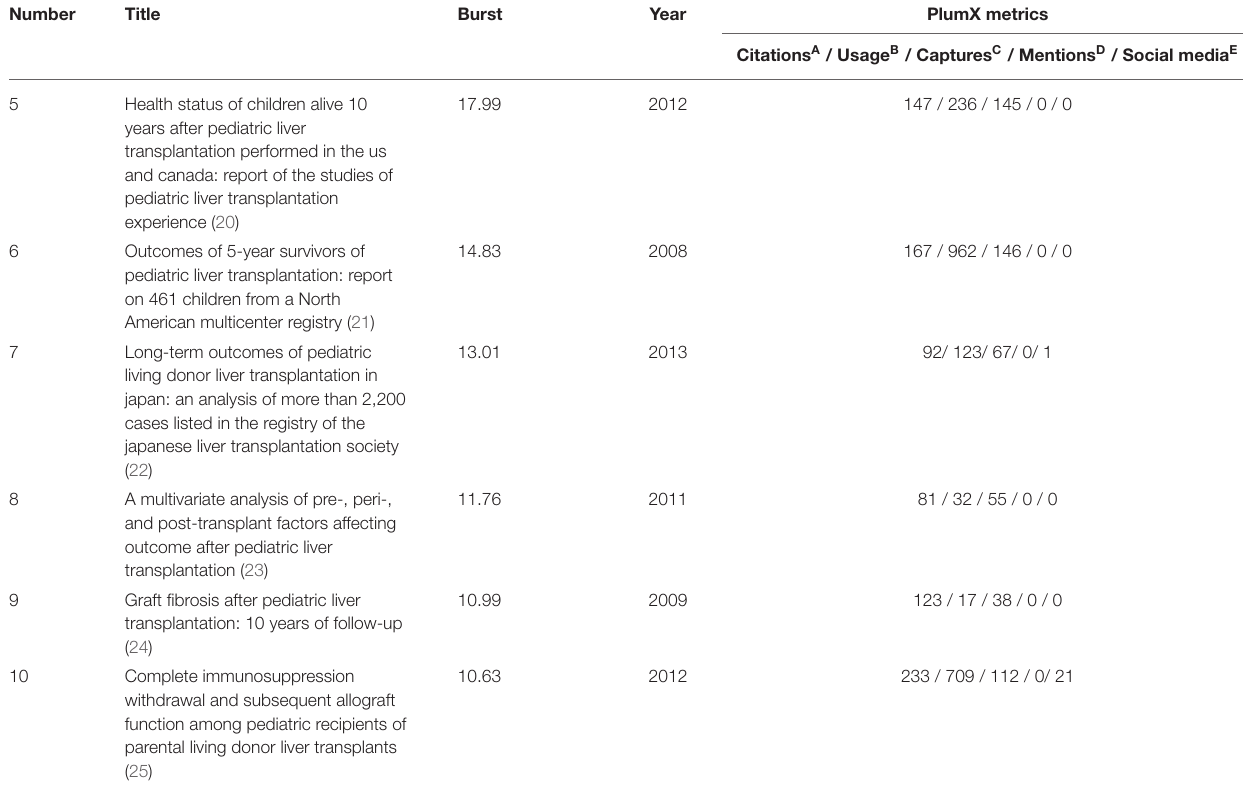
TABLE 3 | Six articles with the strongest citation bursts around 2012. Burst Year PlumX metrics Citations A / Usage B / Captures C / Mentions D / Social media